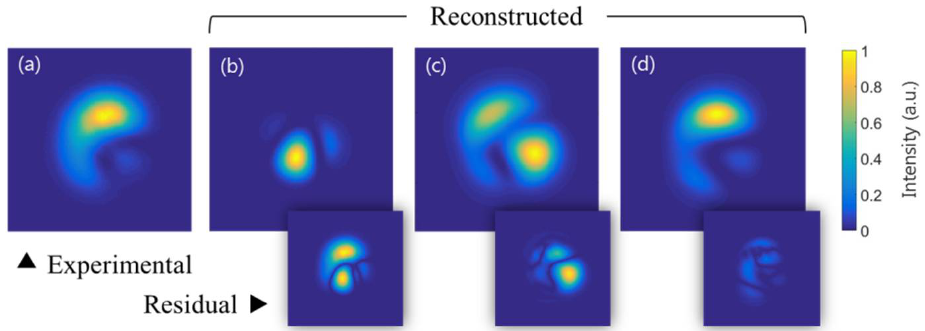
Figure 9. Arbitrary measured transversal intensity distribution ( a ) together with their numerical reconstructions ( b ) when the size is not readjusted through the proposed technique in Section 4, ( c ) when the phases are determined without using the fitting procedure presented in Section 6, and ( d ) when both proposed techniques are employed. The residual intensity patterns are shown below each reconstructed image.